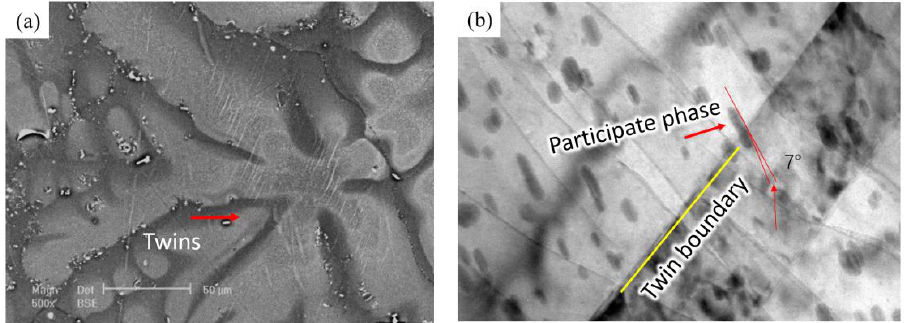
Figure 15. ( a ) The participate phase in the petaloid area, and ( b ) The TEM image of the participated phase at